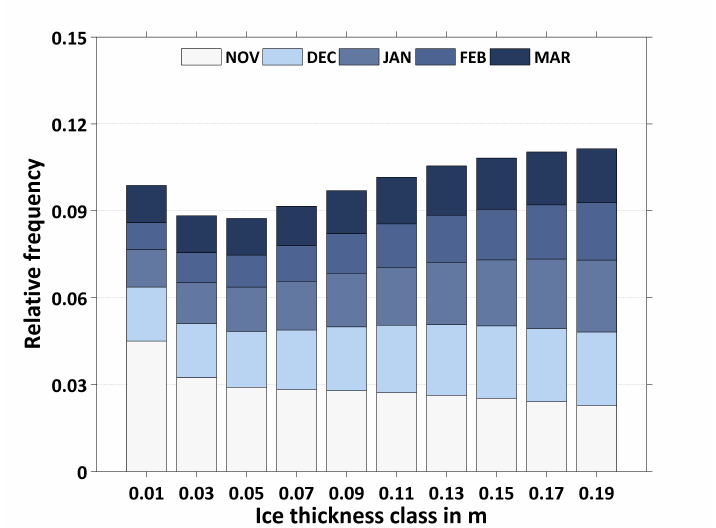
Figure 8. Histogram of the relative thin-ice thickness (TIT) distribution in the NOW polynya, with ice-thickness classes of the 2-cm range ( x axis). Input data are based on daily TIT composites covering the complete freezing season from November to March. The bars indicate the relative distribution of each thickness class from the total number of TIT ď 0.2-m appearances between the winter seasons 2002/2003 and 2014/2015. Contributions of each month with respect to the whole winter season for each thickness class are indicated by the blueish colors (see the